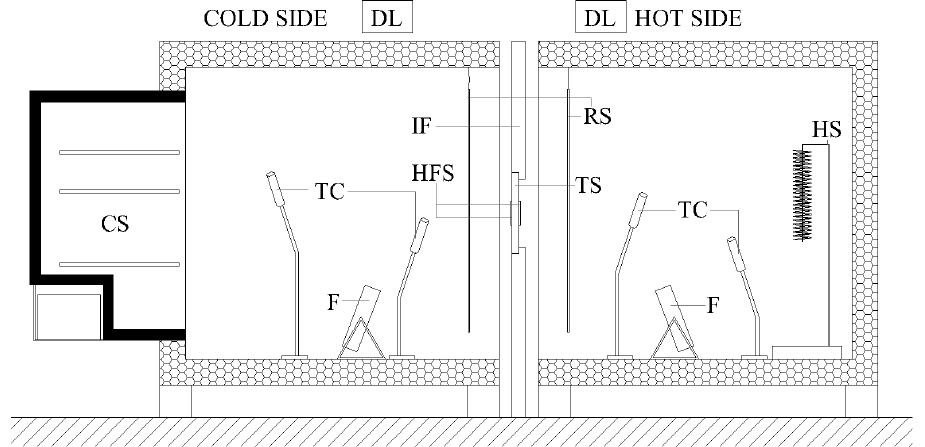
Figure 5. Schematic vertical cross-section of the climatic chambers used for the tests.